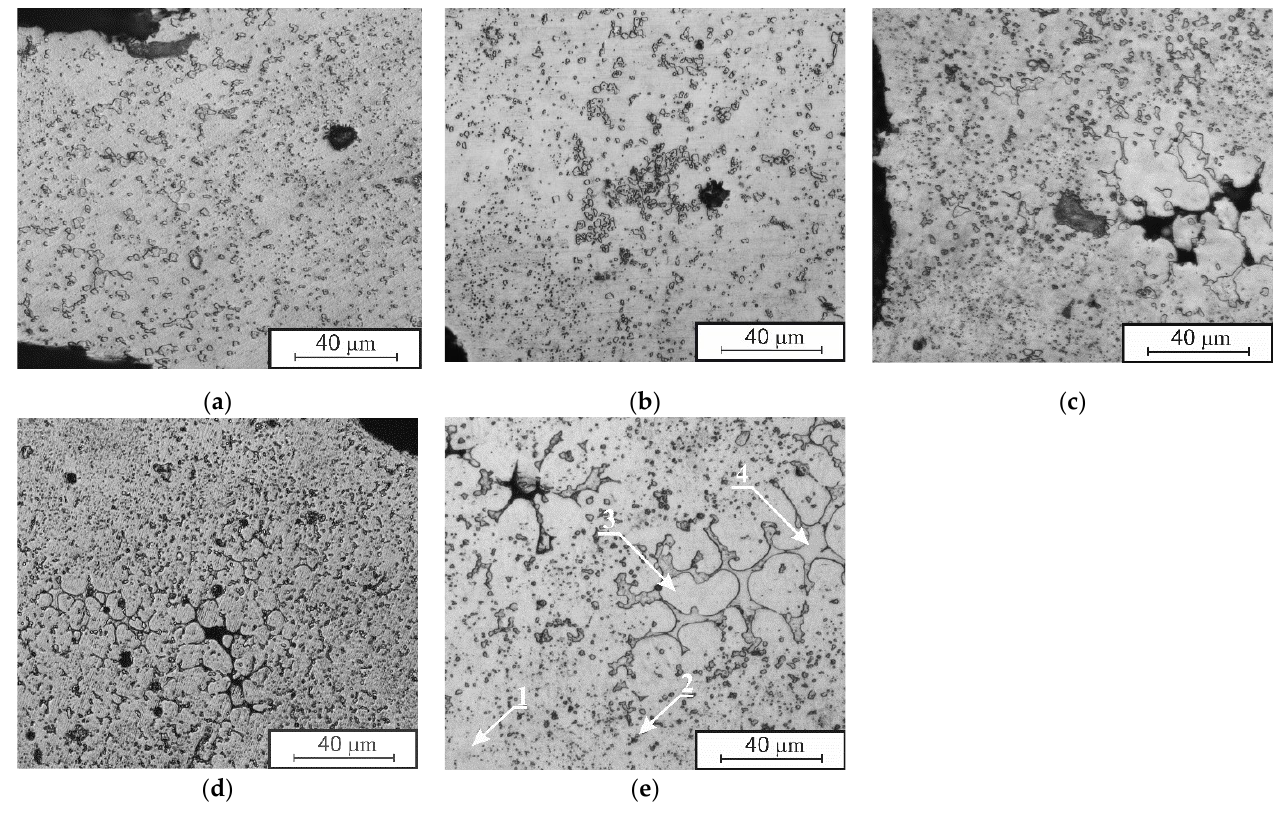
Figure 4. Microstructure of porous alloys: ( a ) TiNi; ( b ) TiNiCu 1 ; ( c ) TiNiCu 3 ; ( d ) TiNiCu 6 ( e ) TiNiCu 10 :